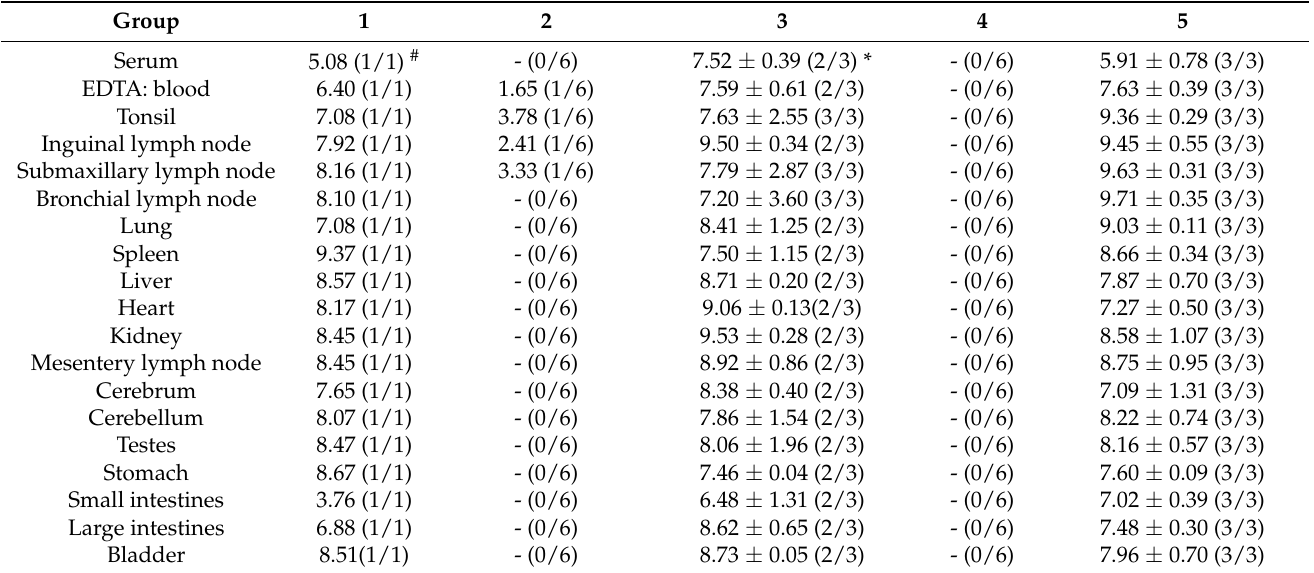
Table 2. CSFV loads detected in various tissues of the piglets through CSFV QRRT-PCR.